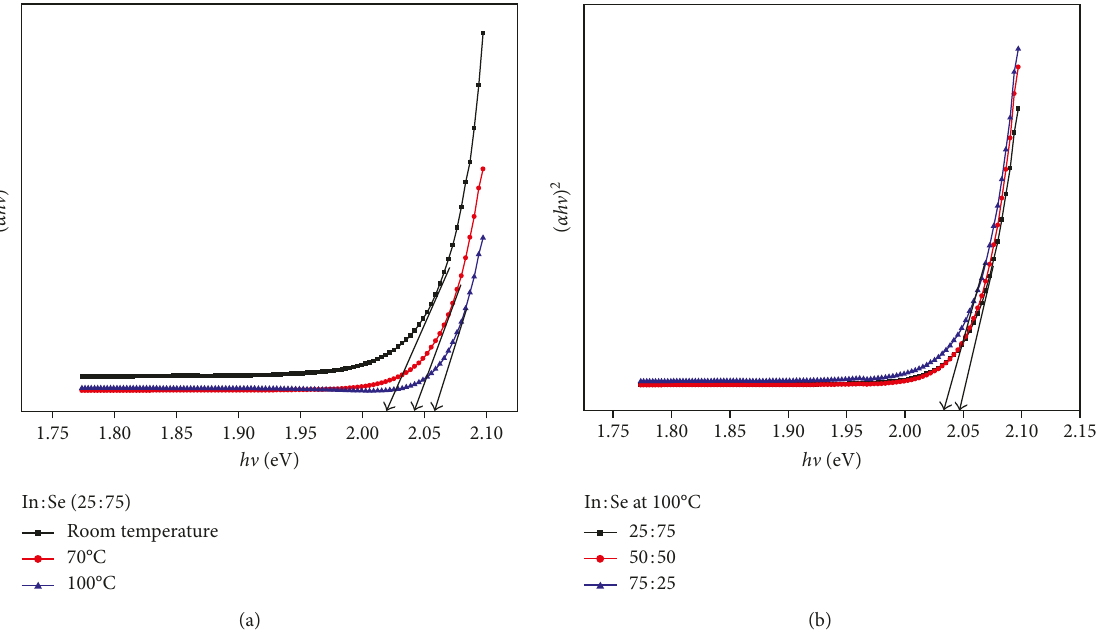
Figure 9: Optical bandgap calculation of InSe bilayer thin films for (a) 25:75 thickness ratio at (b) 100 °